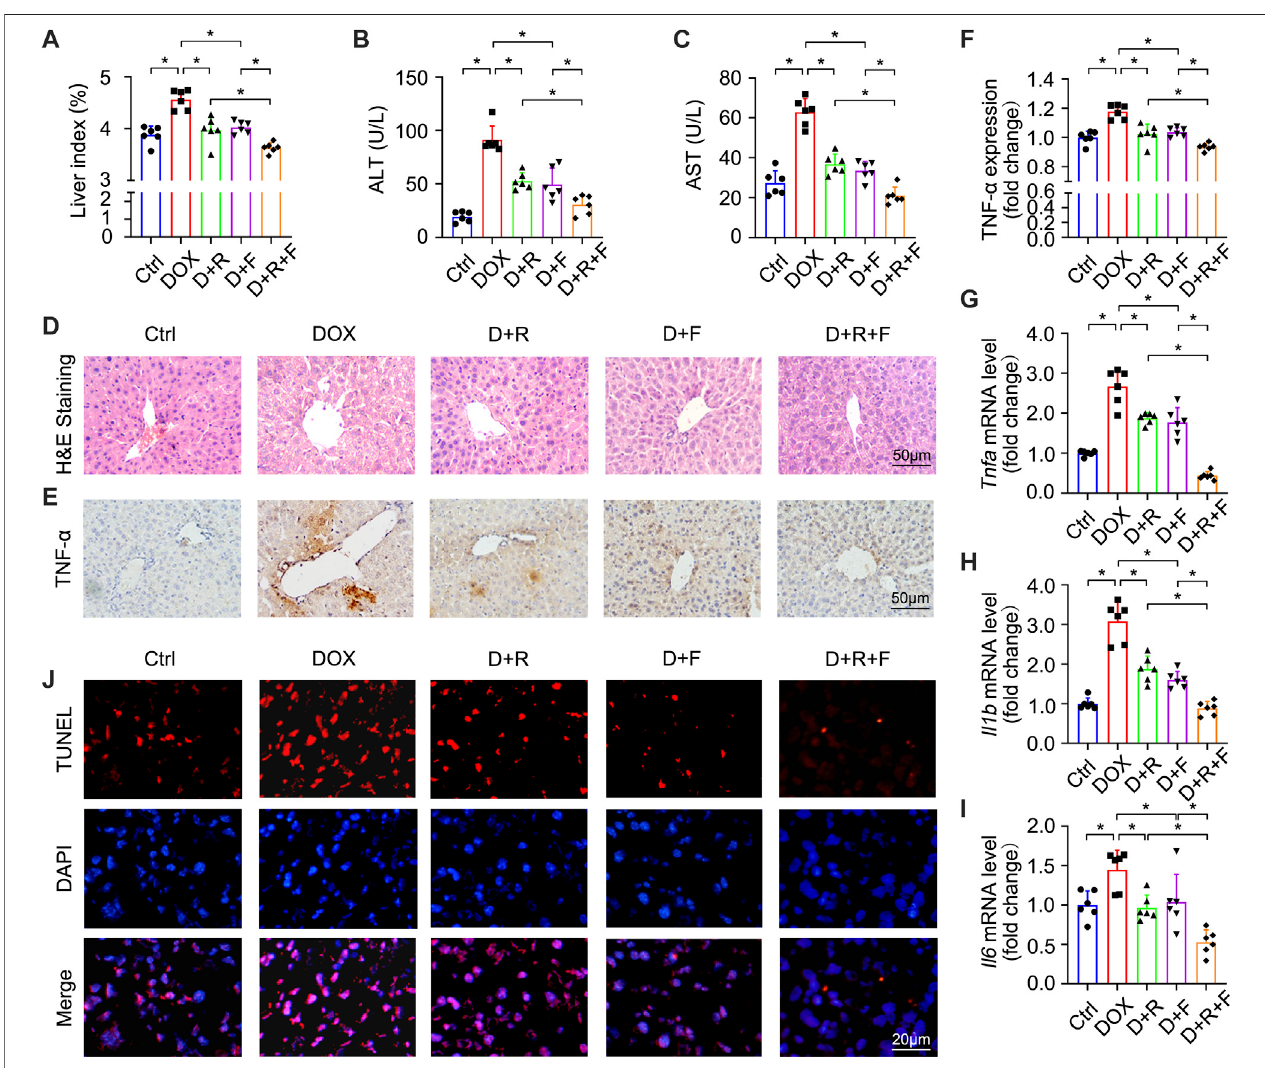
FIGURE 1 | Resveratrol (RES) and fi broblast growth factor 1 (FGF1) co-treatment alleviated liver damage, in fl ammation, and hepatocyte apoptosis in doxorubicin (DOX)-treated mice. (A) Effects of RES and/or FGF1 on the liver index in mice with DOX-induced liver damage ( n = 6). (B,C) Serum levels of ALT and AST after the indicated treatments ( n = 6). (D) Representative light microscopy images showing histopathological changes in liver tissues stained with H&E staining. (E,F) RepresentativemicroscopyimagesshowingIHCstainingofTNF- α inlivertissues( n =6). (G – I) RelativemRNAexpression levelsof Tnfa , Il1b ,and Il6 inhepatocytes ( n = 6). (J) Representative fl uorescence microscopy images of apoptotic hepatocytes labeled by TUNEL staining. Data are expressed as mean ± SD. * p <